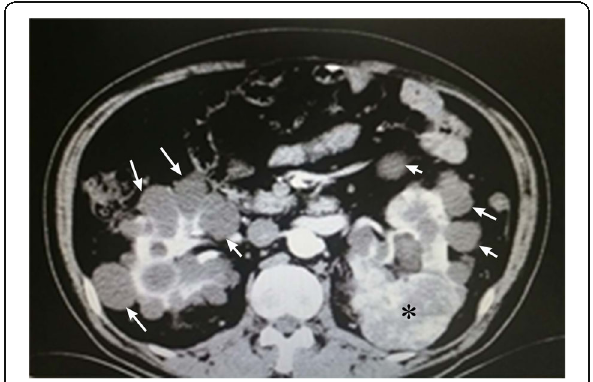
Fig. 3 CT image of bilateral lung metastasis of tumours. A CT image was taken cross both lungs at the thoracic level from the subject of case 1. Arrows indicate multiple metastases of tumours to both sides of the